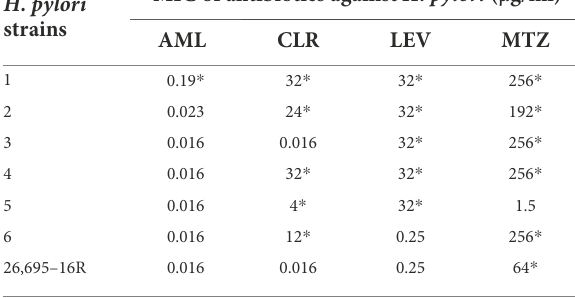
TABLE 3 Minimum inhibitory concentration (MIC) of antibiotics against H.